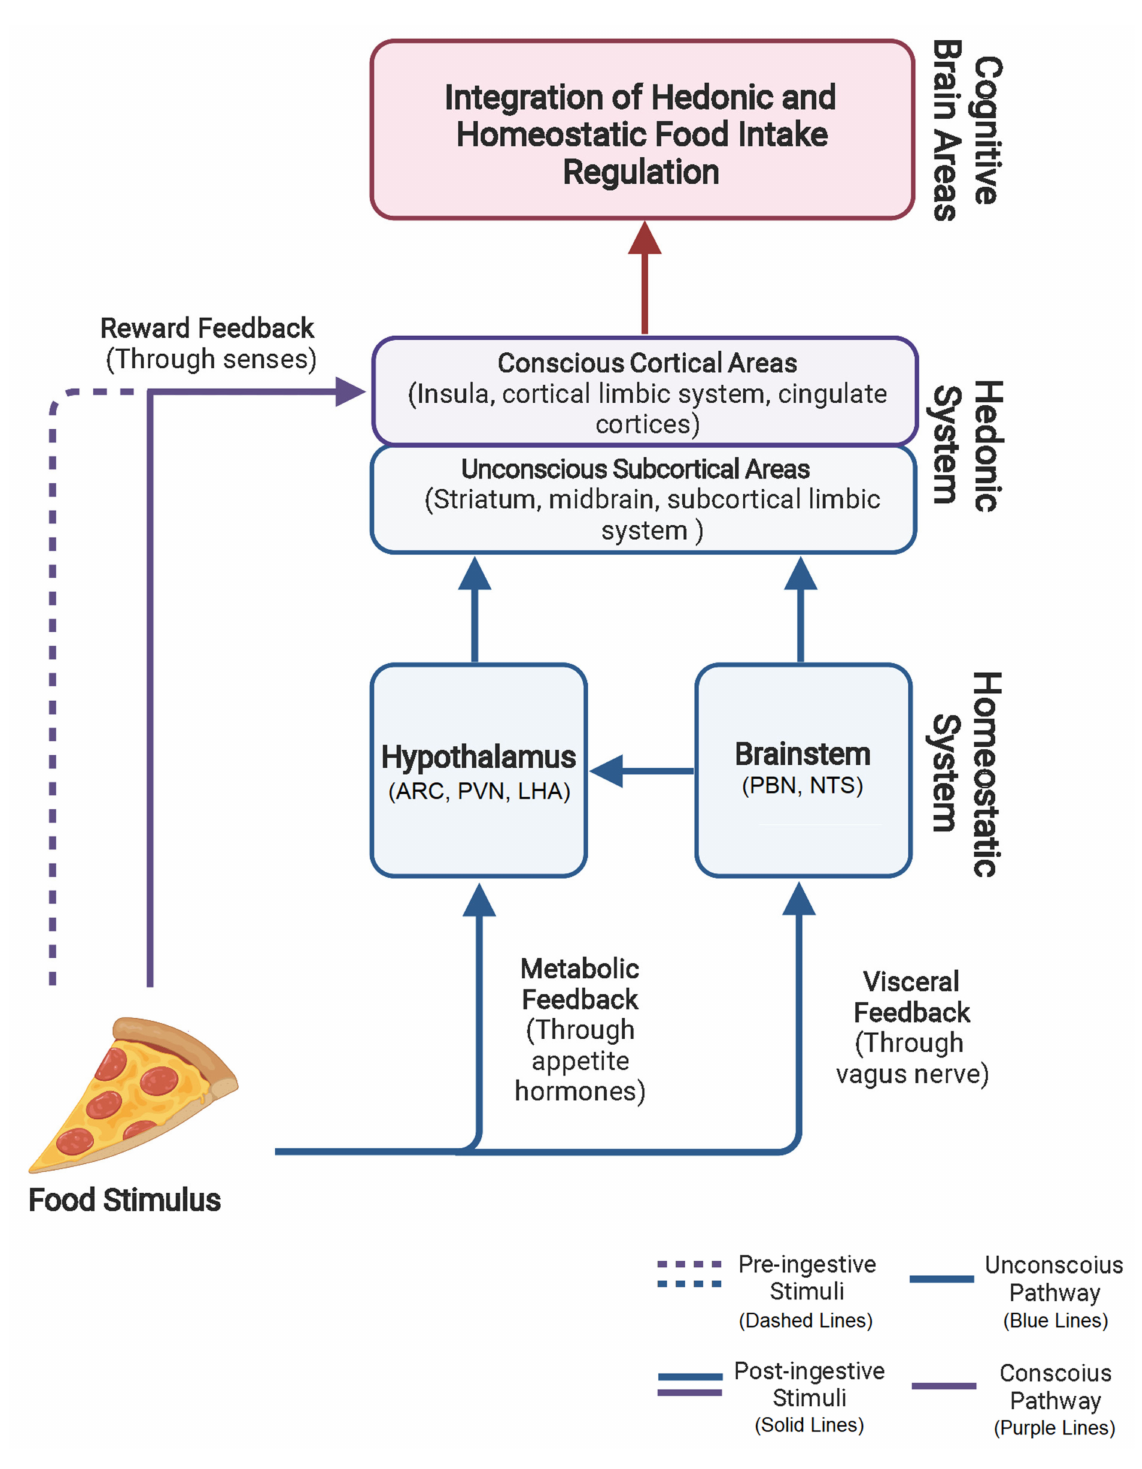
Figure 1. Graphical Abstract. Integration of the hedonic and homeostatic components of food intake regulation. Food stimuli are perceived during a pre-ingestive (dashed lines, purple or blue) phase by the sense of sight, smell, audition, and touch. After food ingestion, sensorial information